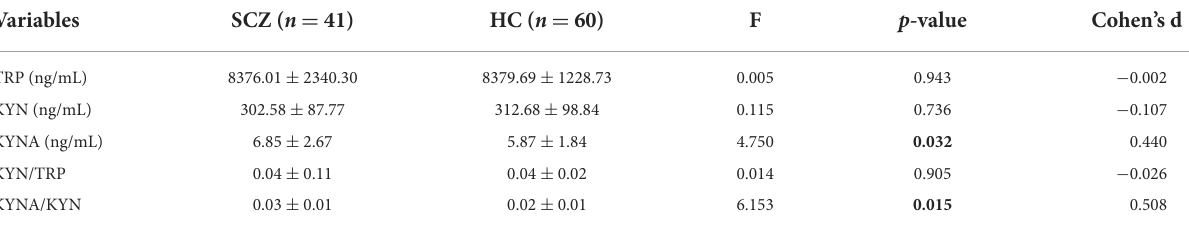
TABLE 2 Comparison of KM between patients with SCZ and HCs. Variables